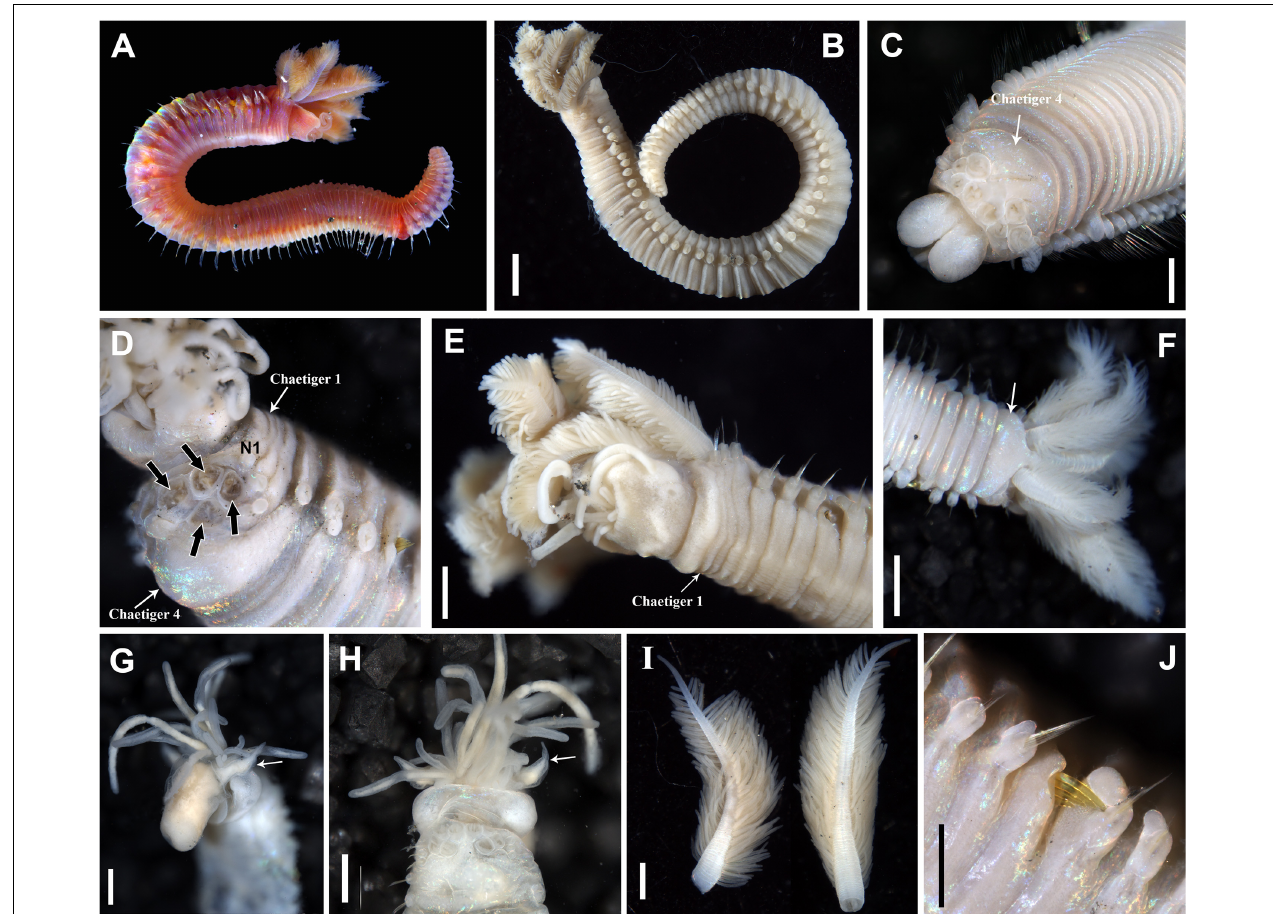
FIGURE 3 | Paralvinella mira n. sp. (A) Paratype (RSIO38207) before fixation, lateral view; (B) Holotype (RSIO38206), lateral view; (C) Paratype (RSIO38087), anterior part, dorsal view, with branchiae removed; (D) Paratype (38204), anterior part, dorsal lateral view, showing arrangement of branchiae (black arrows bordered by white) in relation to the first several segments, N1, notopodium on chaetiger 1; (E) Holotype (RSIO38206), anterior part, ventral lateral view; (F) Paratype (RSIO38087), anterior part, dorsal view; (G) Paratype (RSIO38106), buccal apparatus everted, showing the short, strong and pointed tentacle (white arrow), anterior view; (H) Paratype (RSIO38106), buccal apparatus everted, showing the short, strong and pointed tentacle (white arrow), dorsal view; (I) Branchiae with distal parts devoid of filaments; (J) Notopodia on chaetigers 5–9, showing modified notopodia on chaetiger 7. Scale bar: (B,D,F) , 1 mm; (C,E,G–J) , 0.5